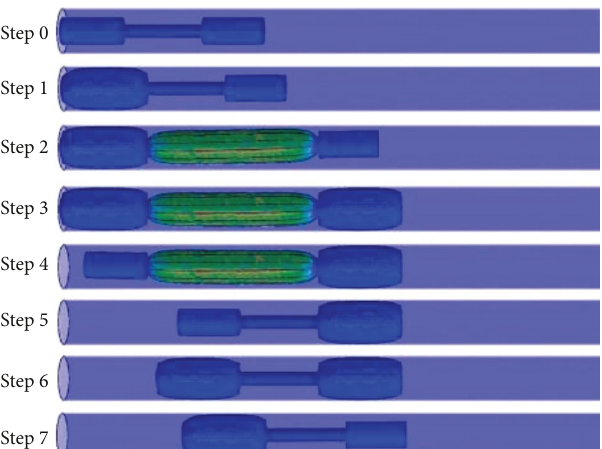
F IGURE 11: Movement in a horizontal straight pipe with 32mm inner